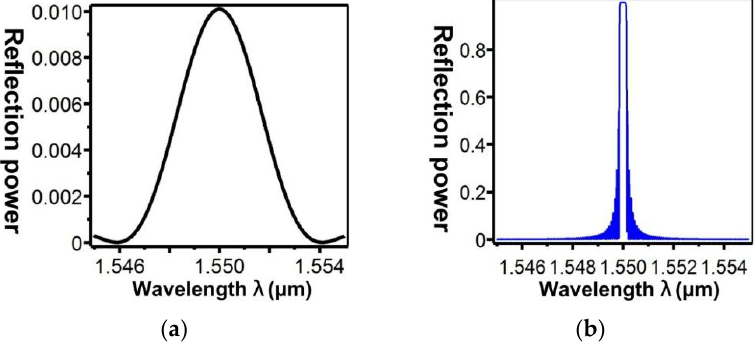
Figure 16. SFBG spectra at Λ SFBG = 0.5371029 μm: ( a ) single SFBG; ( b ) compressed SFBG.